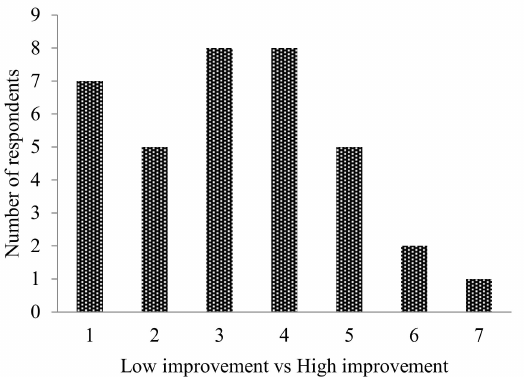
Figure 5. Overall assessment of the indoor environmental quality improvement. Mean rank 3.25, variance 2.58, standard deviation